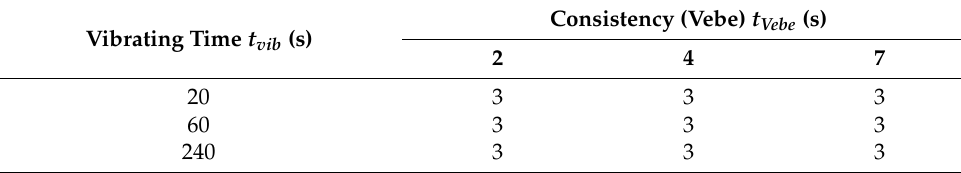
Table 1. The experiment design. Number of specimens in the experiment.